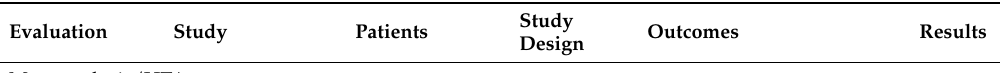
Table A2. Summary of study characteristics and